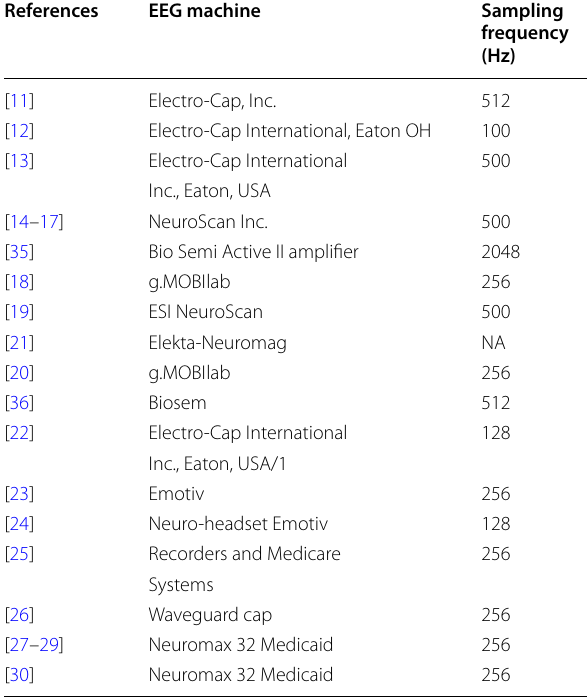
Table 4 EEG machine and sampling